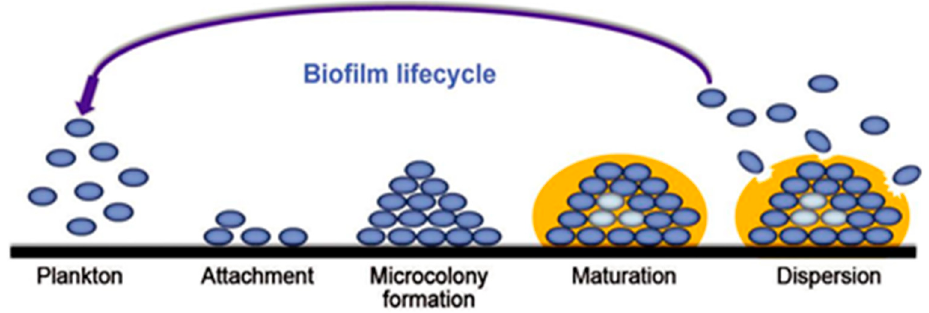
Figure 3. The formation steps of biofilm [19].